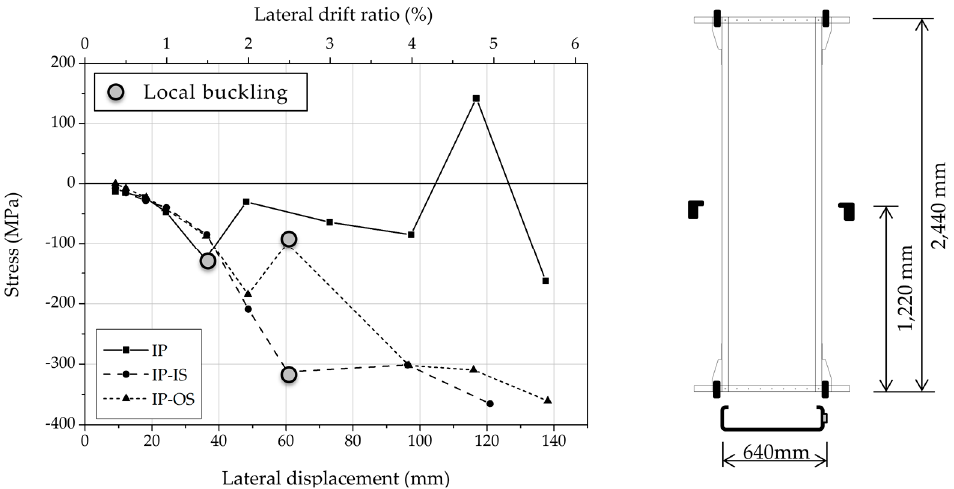
Figure 12. Variation in the stress with drift ratio measured using the strain gauge attached to the vertical direction at a height of 1220 mm at the center of the flange of the integrated panel.